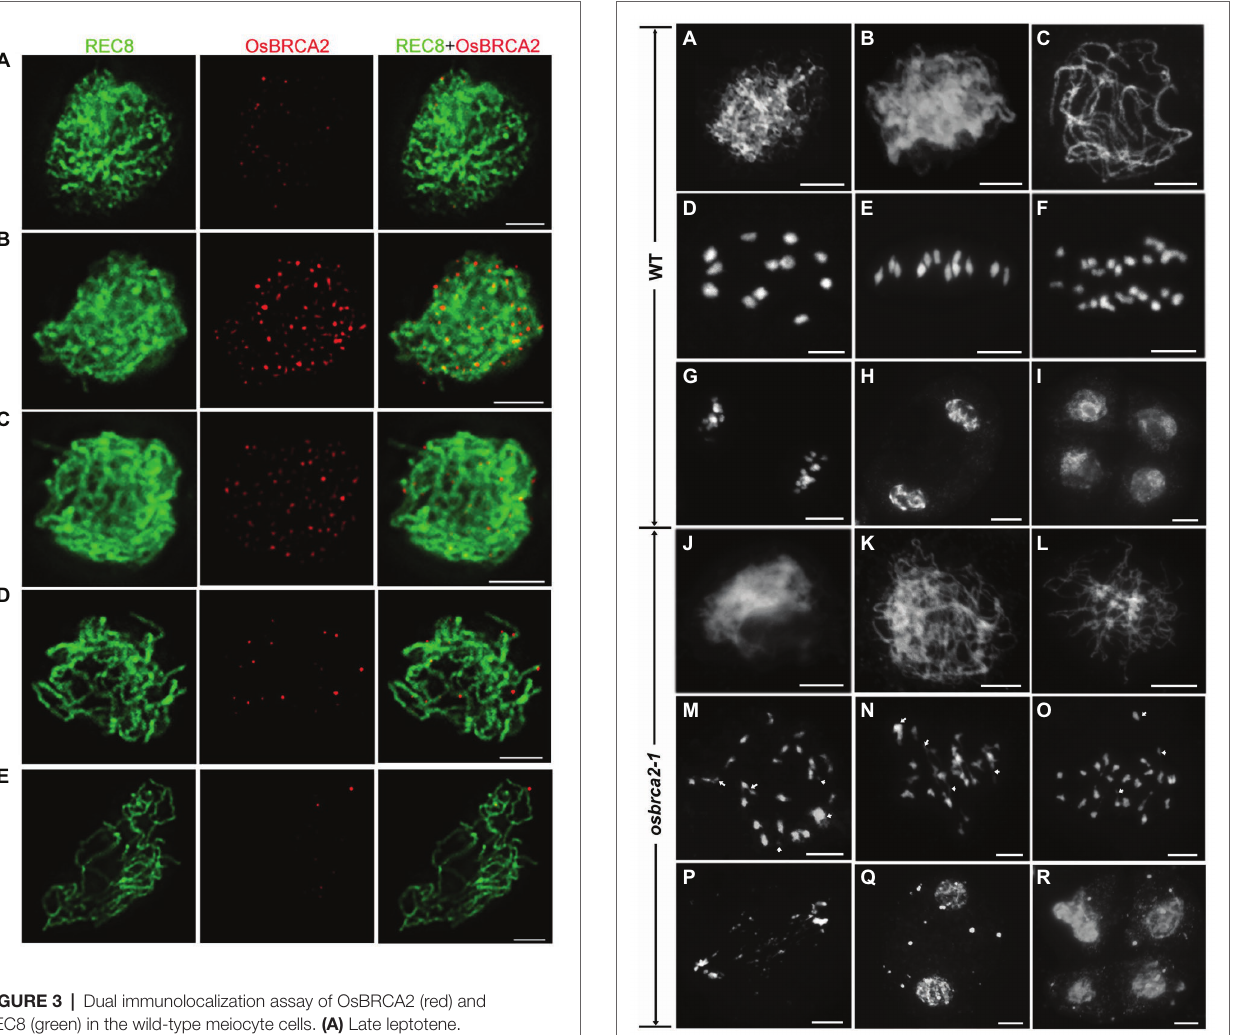
type and osbrca2-1 . Chromosome behavior of male meiocytes of wild type (A–I) and osbrca2-1 (J–R) at various stages. (A,J) Leptotene. (B,K) Zygotene. (C,L) Pachytene. (D,M) Diakinesis. (E,N) Metaphase I. (F,O) Anaphase I. (G,P) Telophase I. (H,Q) Dyad. (I,R) Tetrad. Arrows indicated the abnormal chromosomes. Bars = 5 μ